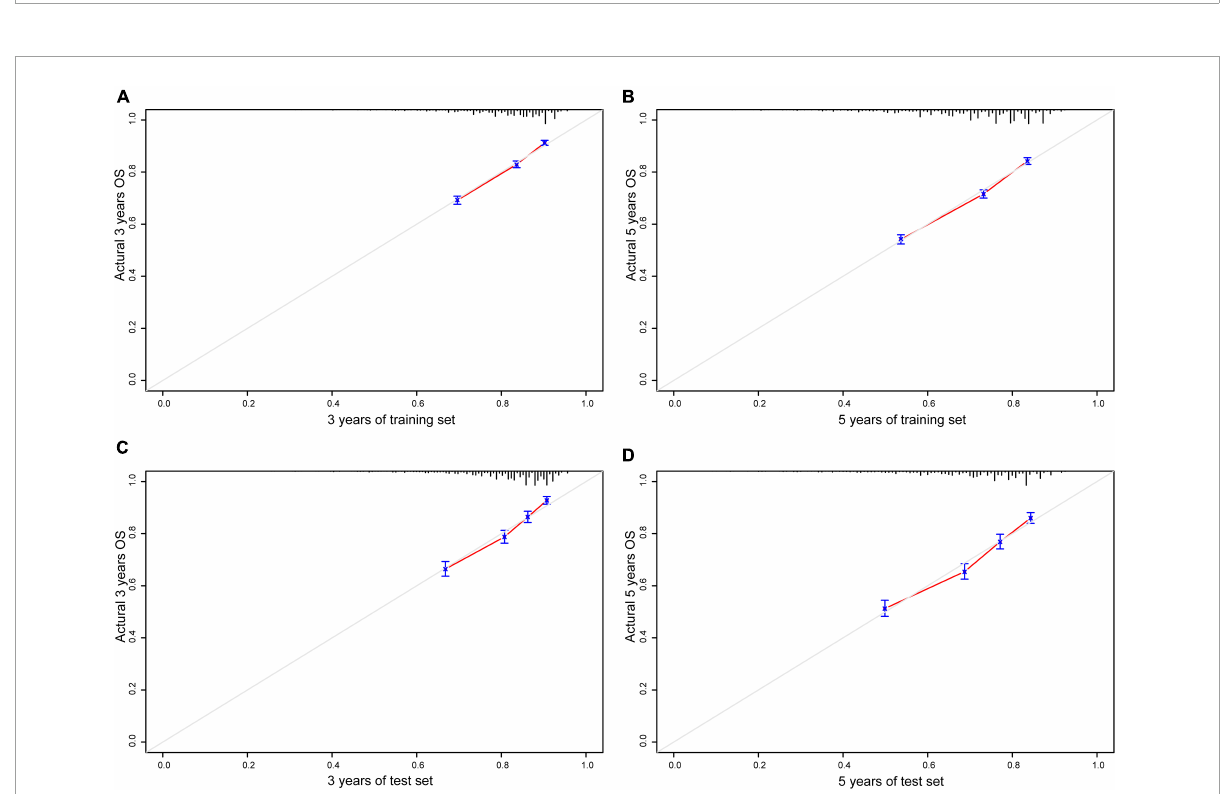
FIGURE3 Calibration plots of nomogram model. (A) A total of 3 years of training set; (B) 5 years of training set; (C) 3 years of test set; (D) 5 years of test set; gray line, actual observation; red line, prediction survival